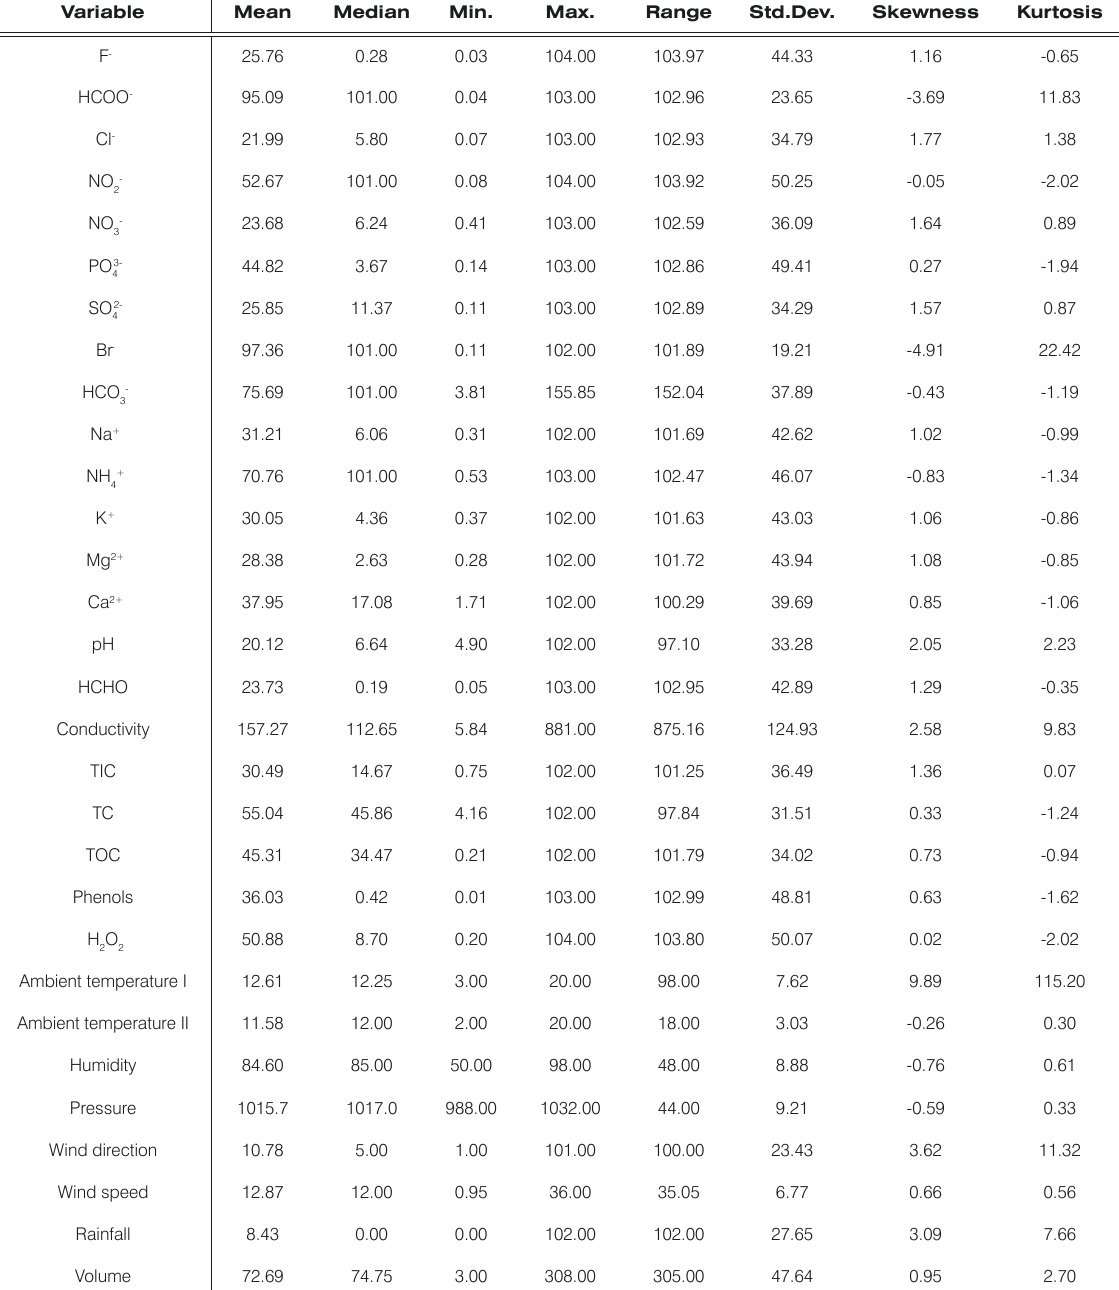
Table 3. Basic statistical parameters of all characteristics (160 samples)